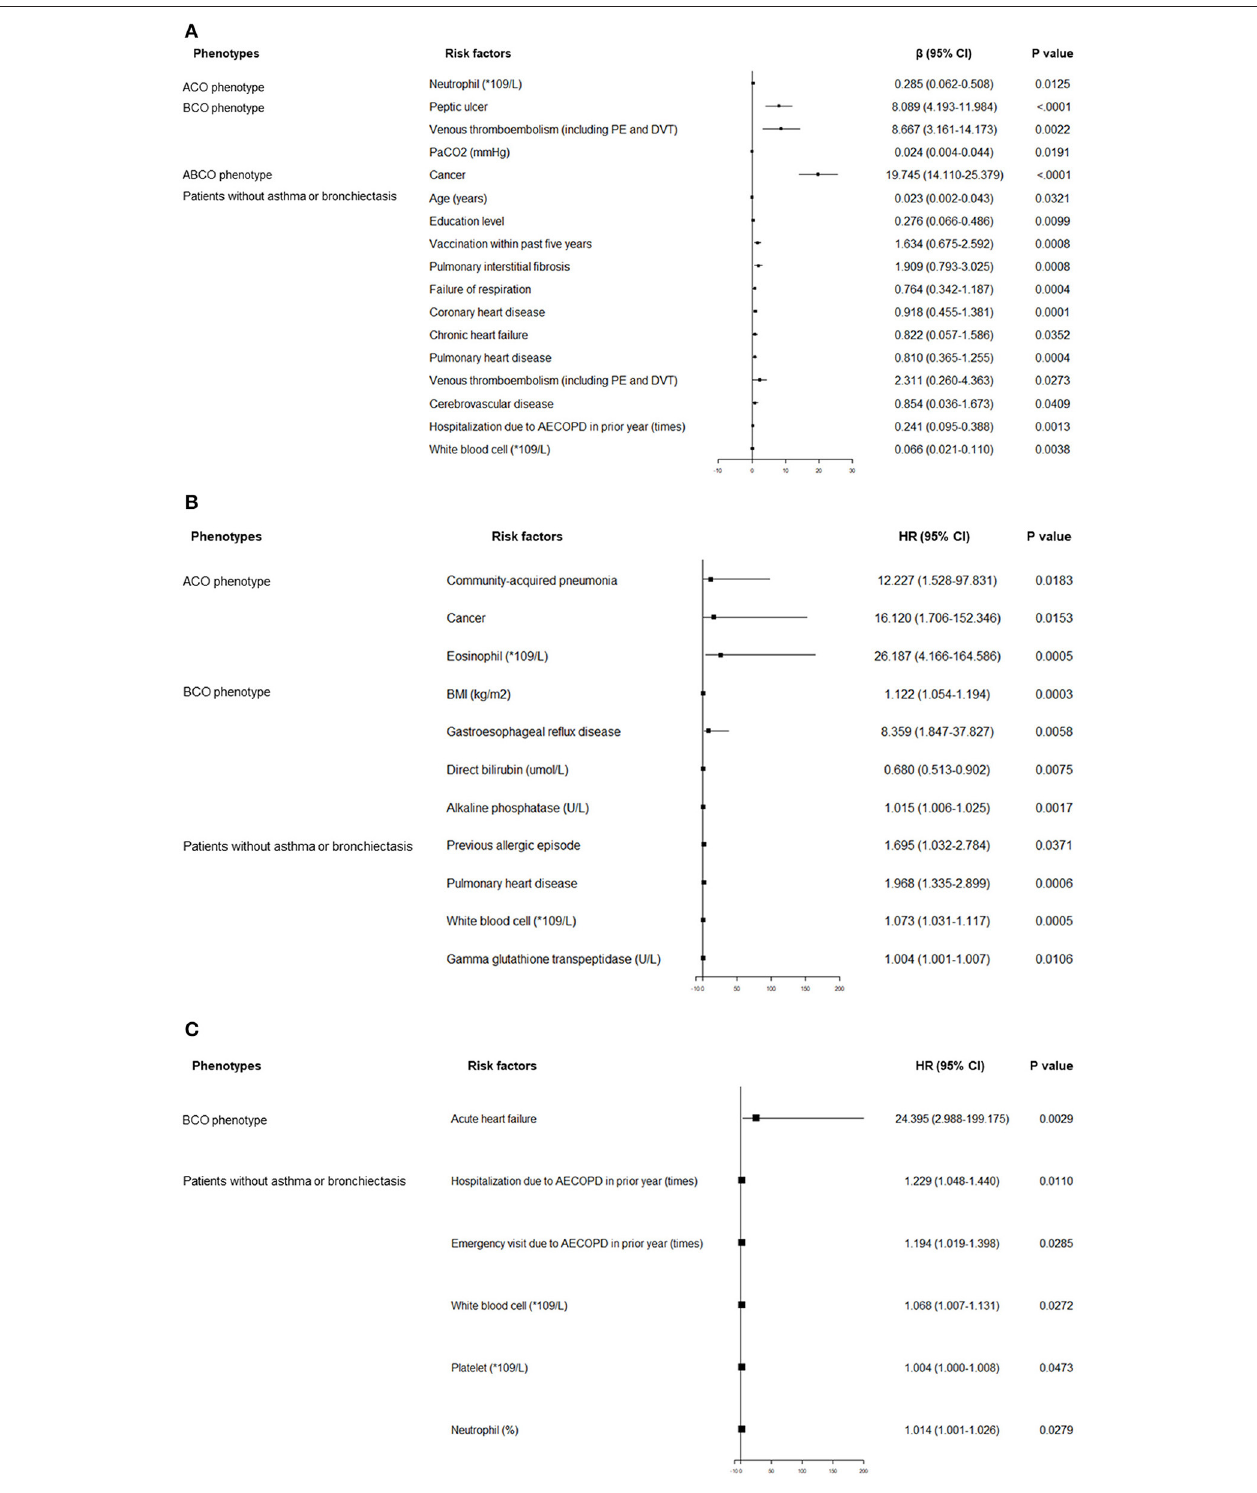
FIGURE 2 | (A) Independent risk factors associated with length of index hospital stay. (B) Independent risk factors associated with recurrence of AECOPD within 30 days after the index hospital discharge. (C) Independent risk factors associated with exacerbation-related hospital readmission within 30 days after the index hospital discharge. ABCO, chronic obstructive pulmonary disease patients comorbid with asthma and bronchiectasis; ACO, asthma-chronic obstructive pulmonary disease overlap; AECOPD, acute exacerbation of chronic obstructive pulmonary disease; BCO, bronchiectasis-chronic obstructive pulmonary disease overlap; BMI, body mass index; CI, confidence interval; DVT, deep venous thrombosis; HR, hazard ratio; ICU, intensive care unit; PE, pulmonary embolism; RICU, respiratory intensive care unit.